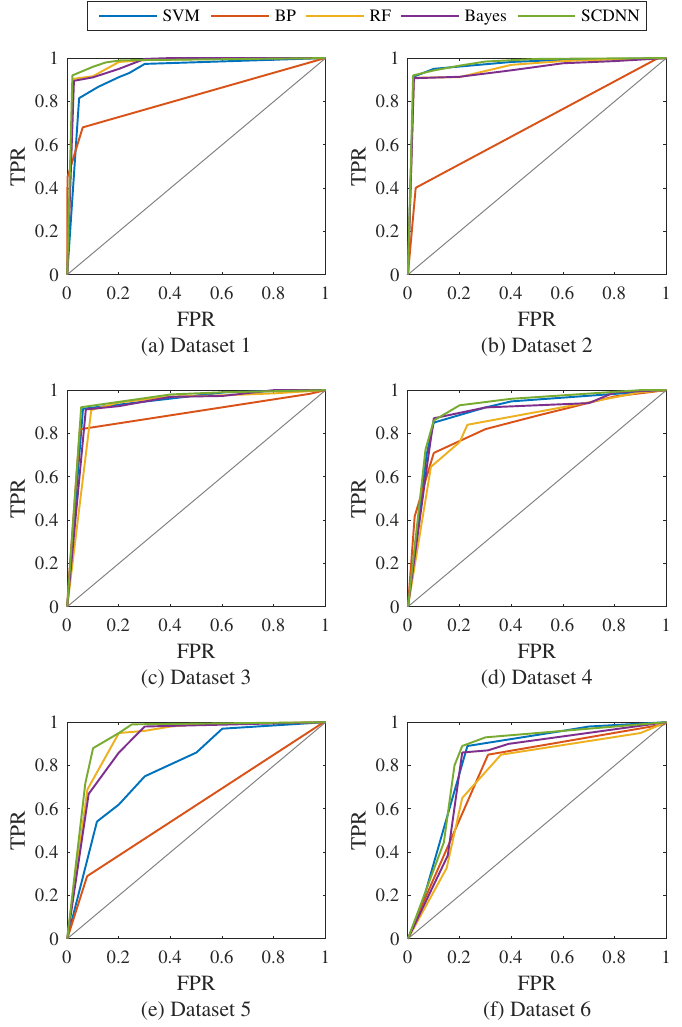
Figure 7. ( a–f ) Receiver operating curves (ROC) curves of the five models in the six datasets, shown with optimal values of k and σ